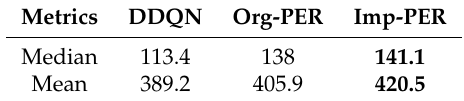
Table 7. Median and mean normalized score of all games (%). Bold font shows the best